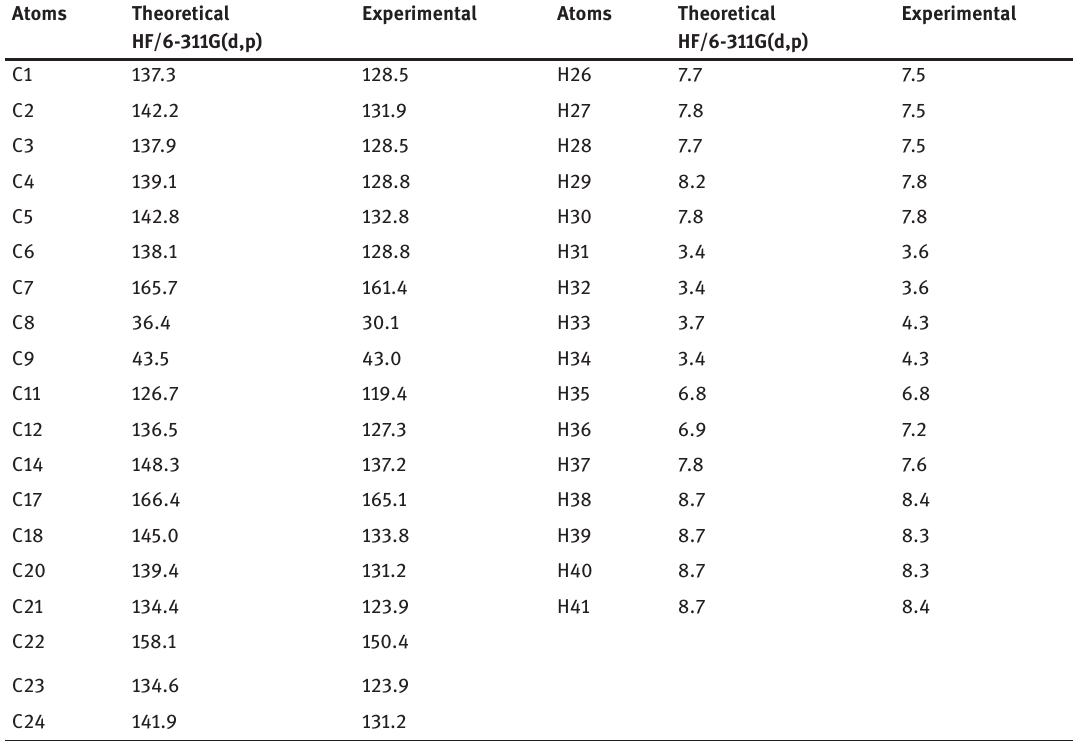
Table 5: Theoretical and experimental 13 C and 1 H NMR chemical shift values (ppm) with respect to TMS in DMSO solution of the IPAONM